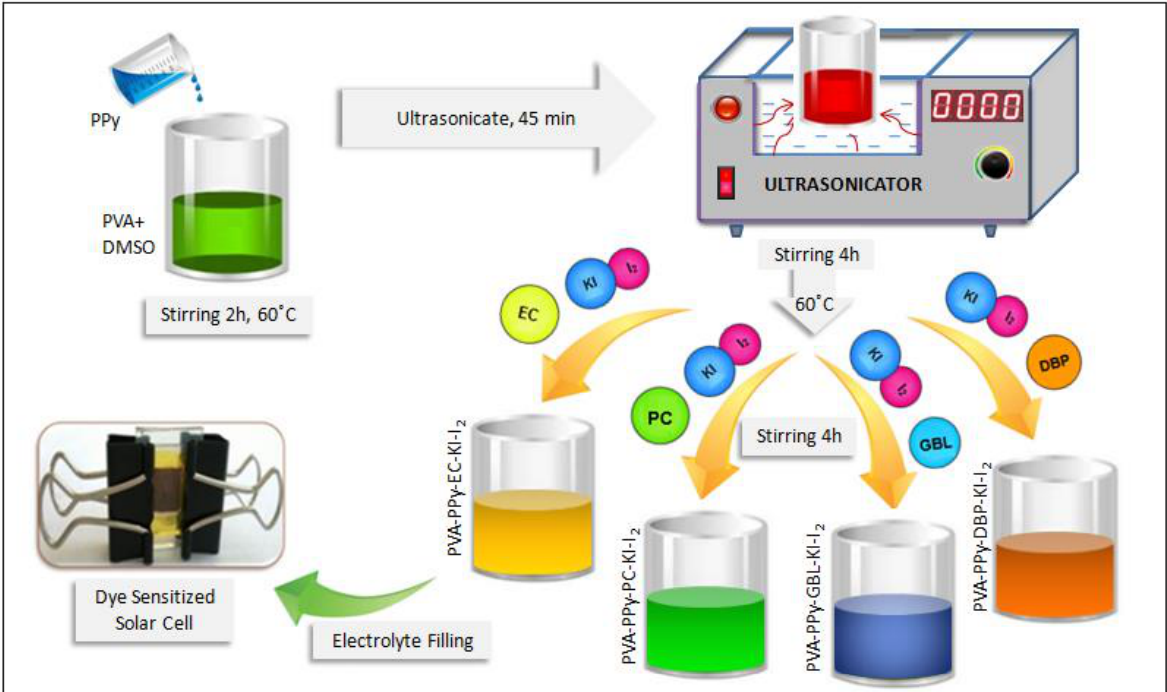
Figure 1. Preparation of the quasi-solid-state conducting polymer electrolyte with different plasticizers. (90 [85 PVA: 10PPy: 5KI:I 2 ]:10x, where x = EC, PC, GBL, and DBP).